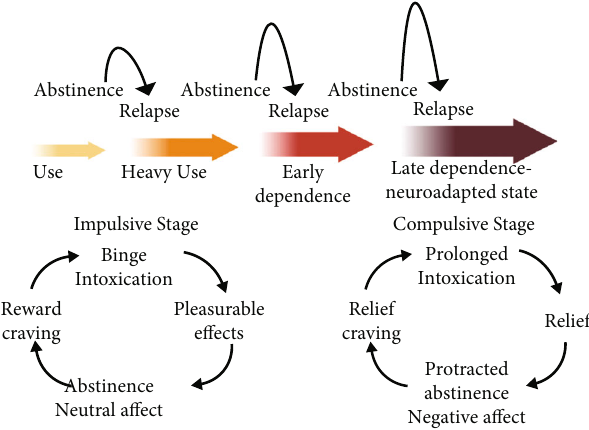
Figure 1: Transition from the impulsive (acute) to the compulsive (abuse) patterns of drug-taking. Adapted from Meyer and Quenzer [8] using